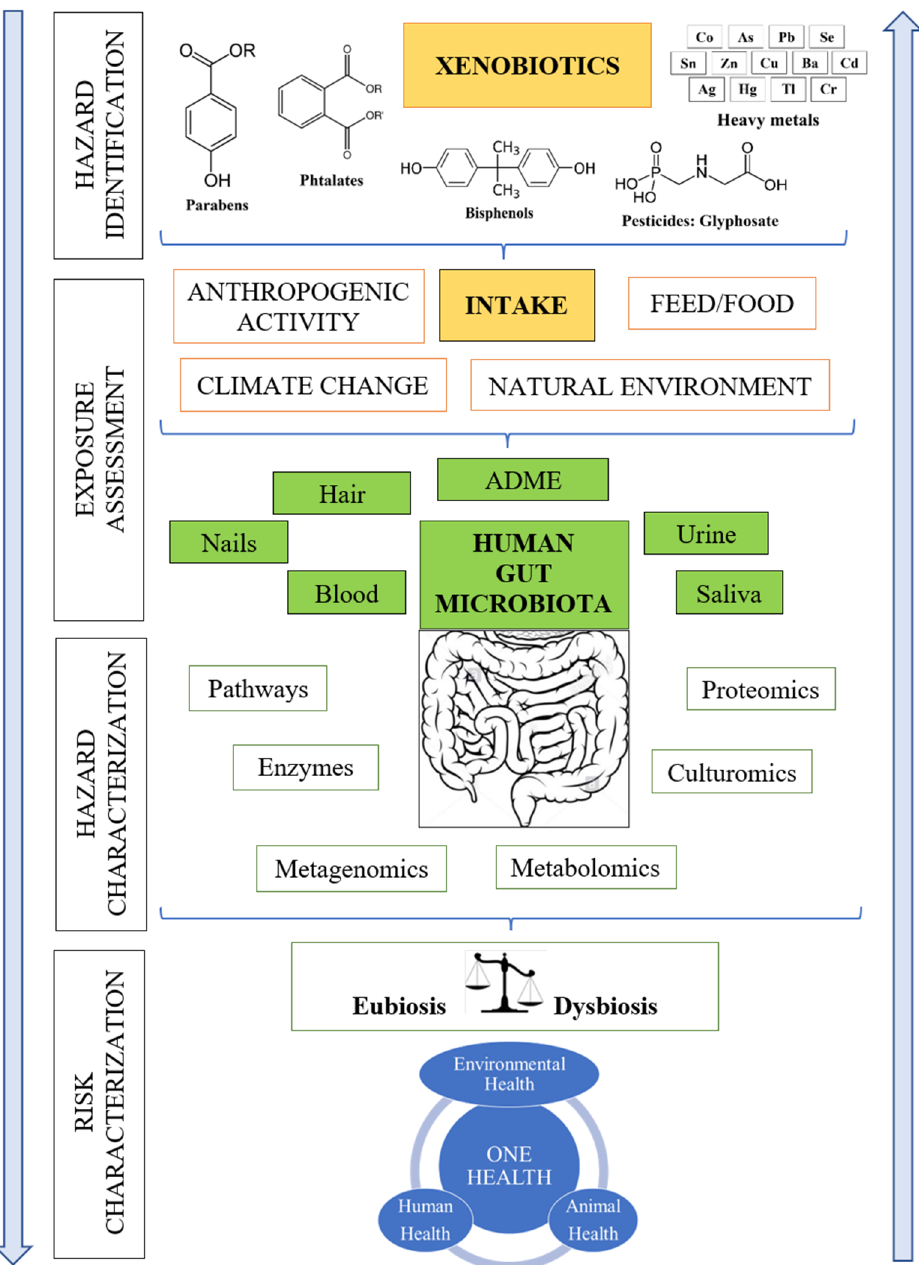
Figure 1. Risk assessment of xenobiotics in an accordance with the One Health approach.